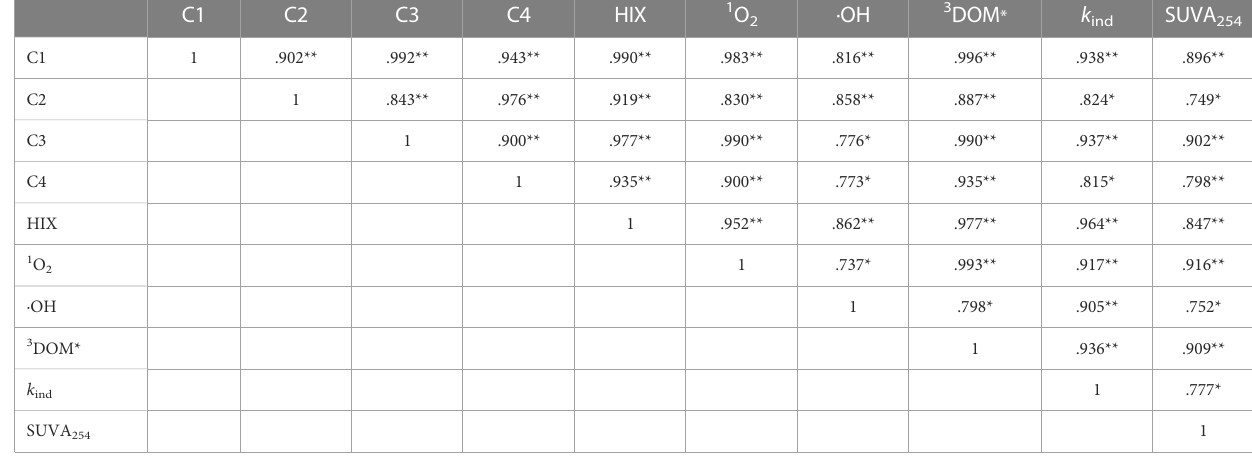
TABLE 1 Correlations among the OFX indirect photodegradation rate, DOM components, HIX, SUVA 254 , and the steady-state concentrations of